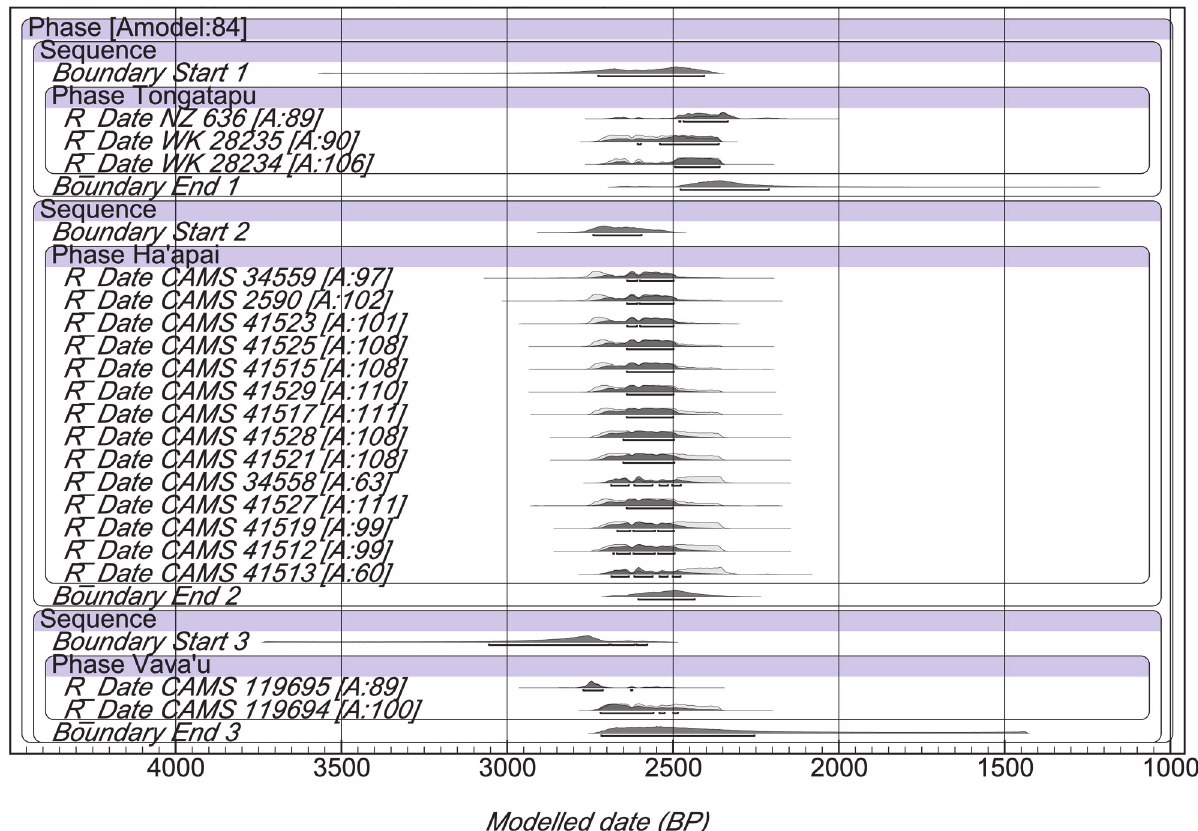
Fig 3. Bayesian overlap model of Tongan Polynesian Plainware dates. Radiocarbon dates are calibrated at 68.2% using SHCal13 atmospheric curve [26] while the plot is a generated output of OxCal Version 4.2.3. S2 Table provides detailed data for individual dates and the